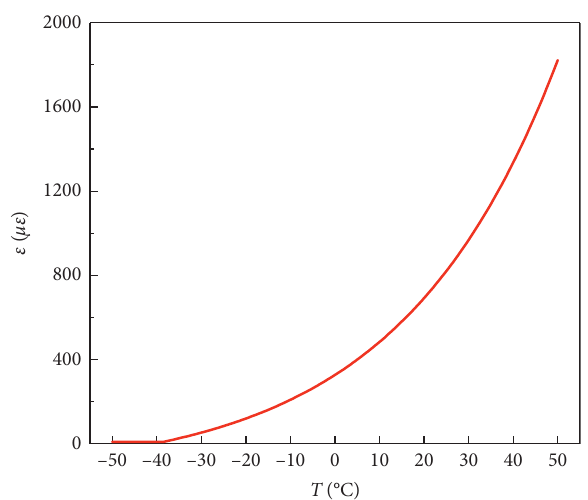
Figure 14: Temperature fatigue life surface and scattering points.